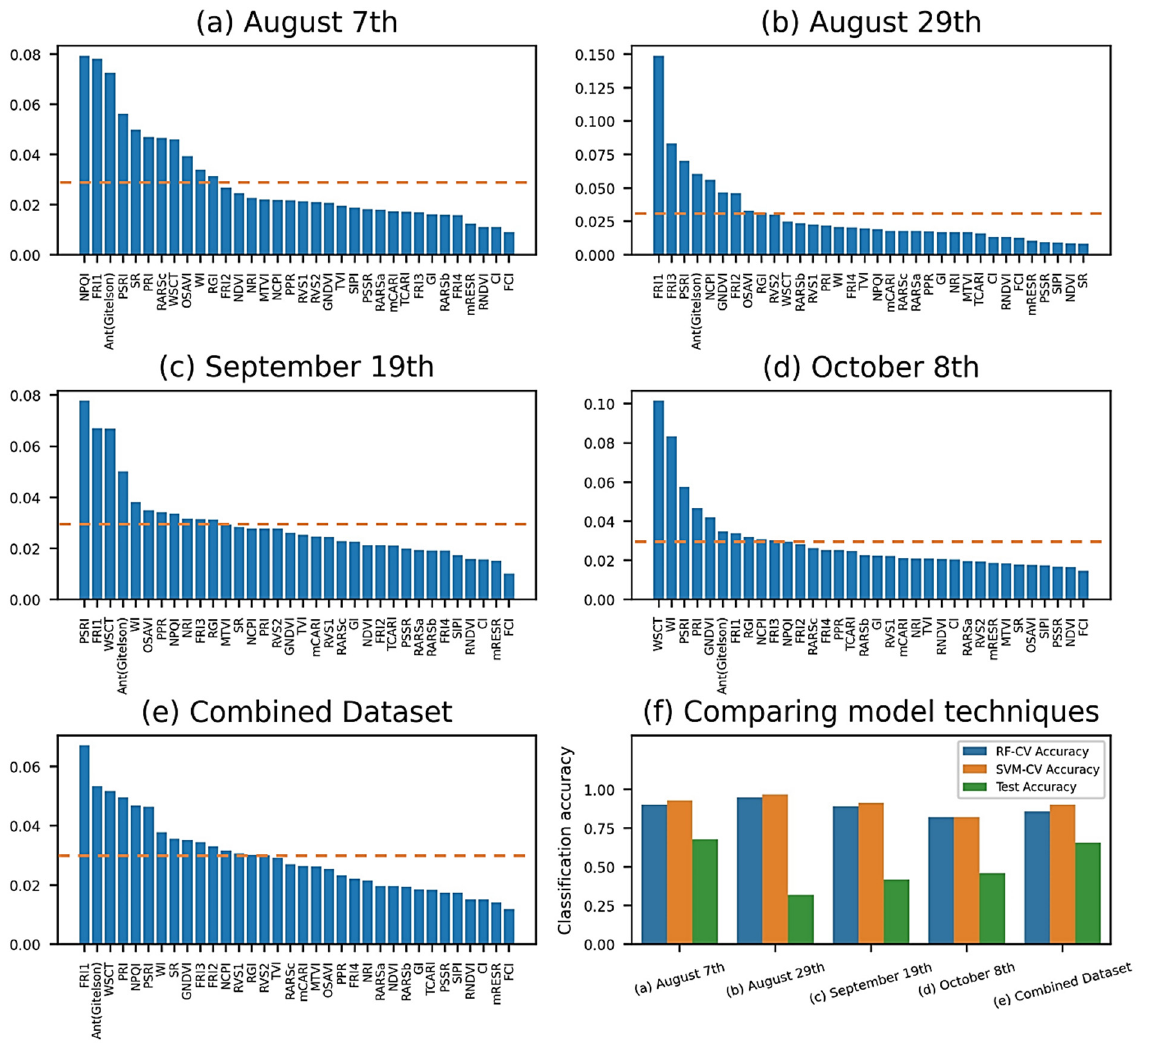
Figure 7. Mean decreased impurity (MDI) feature importance among datasets ( a – e ). The normalized scores for 34 VIs were ranked by their respective classification ability. The dashed lines indicate the mean of the scores, which was a threshold used to allow selected VIs to enter the machine learning pipeline. Vegetation-index-based classification performance ( f ). In the training process, 5-fold cross validation accuracies from SVM pipelines (orange bars) were uniformly higher than the ones from RF pipelines (blue bars), and thus SVM pipelines were selected for testing (green bars).